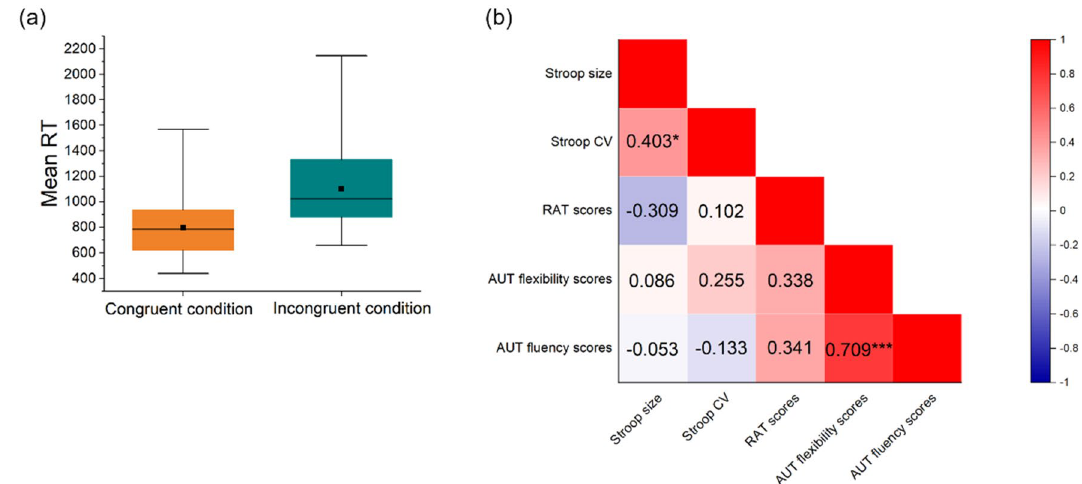
Figure 1. Statistics of mean RT in the Stroop task and inter-correlations between behavioral assessments. ( a ) Mean reaction time (RT) in (corresponding) incongruent condition was larger than RT in (corresponding) congruent condition; ( b ) inter-correlation between the size of Stroop effect, RT-CV of Stroop task, RAT scores, AUT flexibility scores and AUT fluency scores. *p < 0.05, ***p <